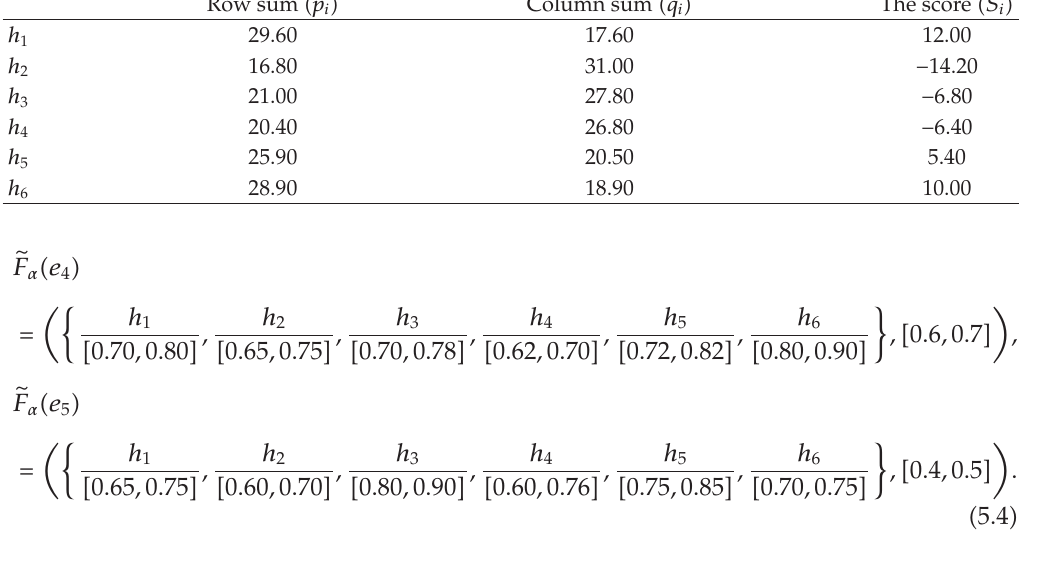
Table 3: The score of h i about (cid:2) F α